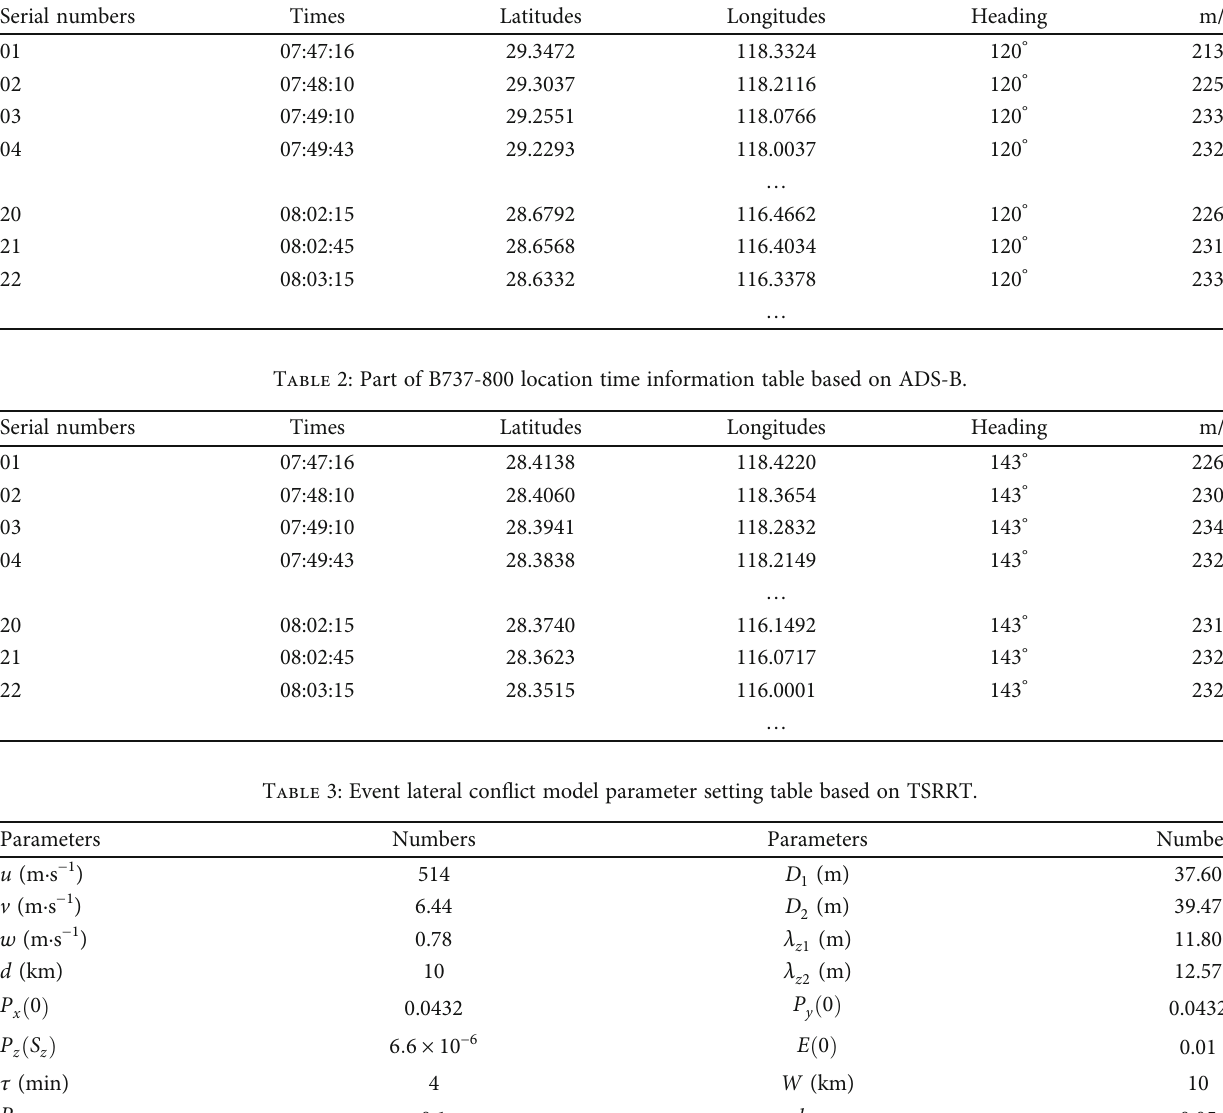
Table 1: Part of the A320 passenger location and time information table based on ADS-B.